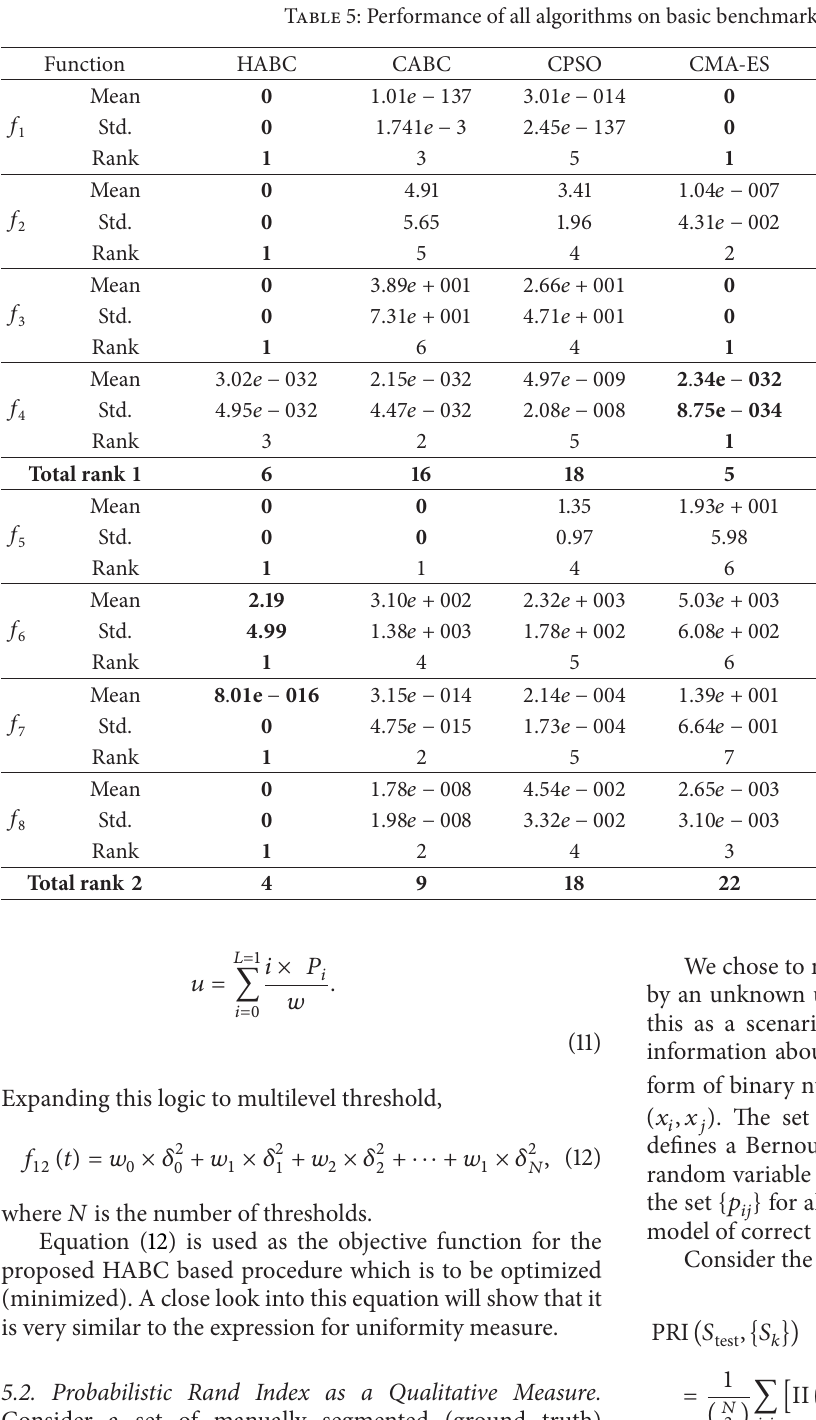
Table 5: Performance of all algorithms on basic benchmark functions f